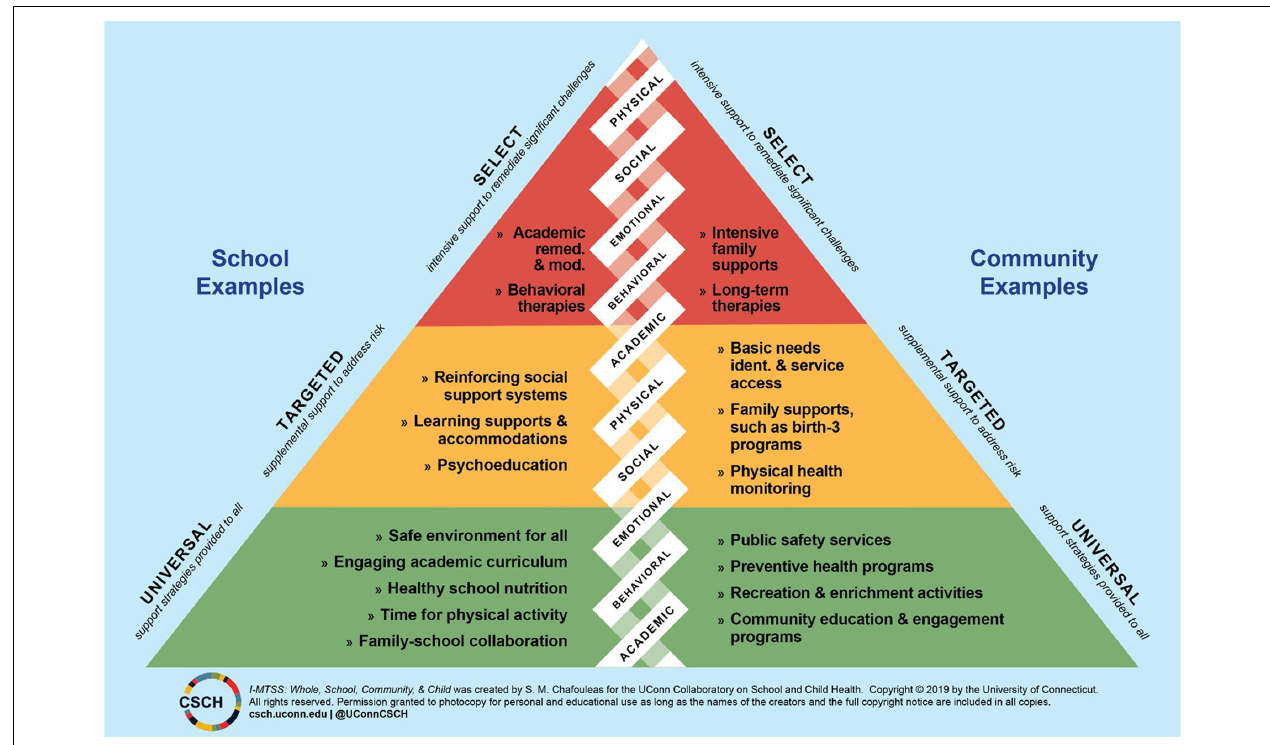
FIGURE 2 | Visual example of multi-tiered systems of support that integrates whole school, community, and child (Chafouleas, 2019). Image reproduced with permission from the Collaboratory on School and Child Health at the University of